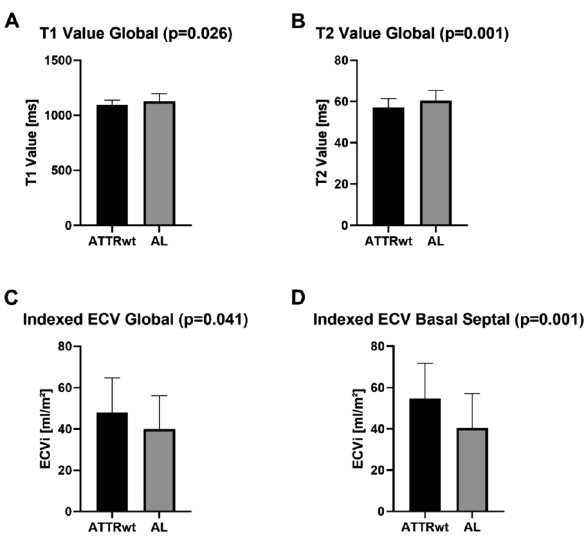
Figure 2. Graph illustrating the differences between ATTRwt and AL amyloidosis group regarding ( A ) global T1-mapping values, ( B ) global T2-mapping values, ( C ) global indexed extracellular volume and ( D ) indexed extracellular volume basal septal; p -value < 0.05 is considered as